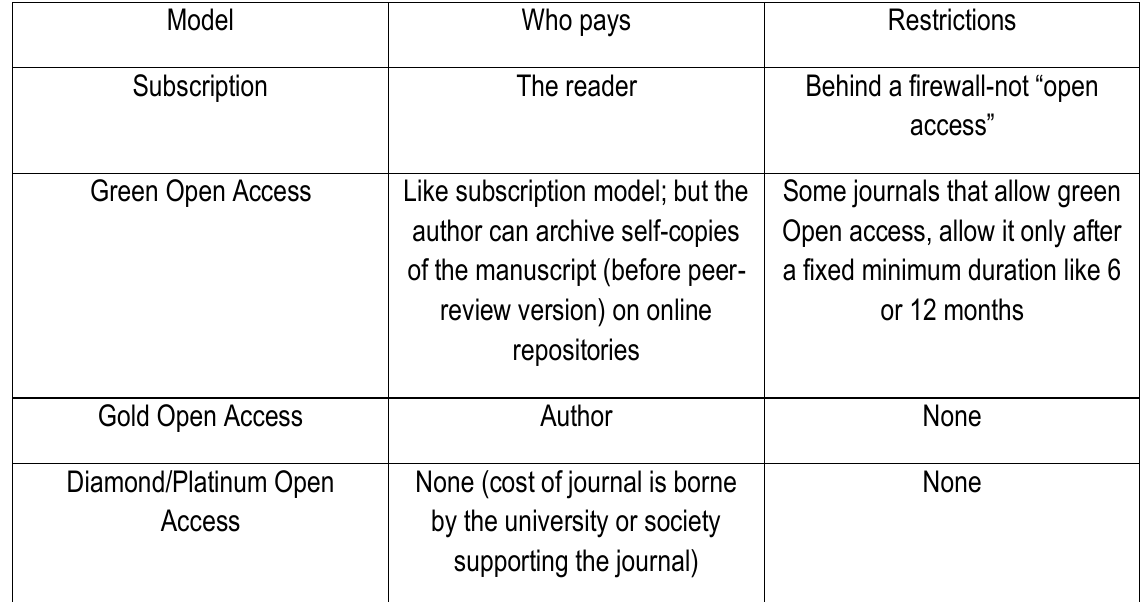
Table 1. Different publication